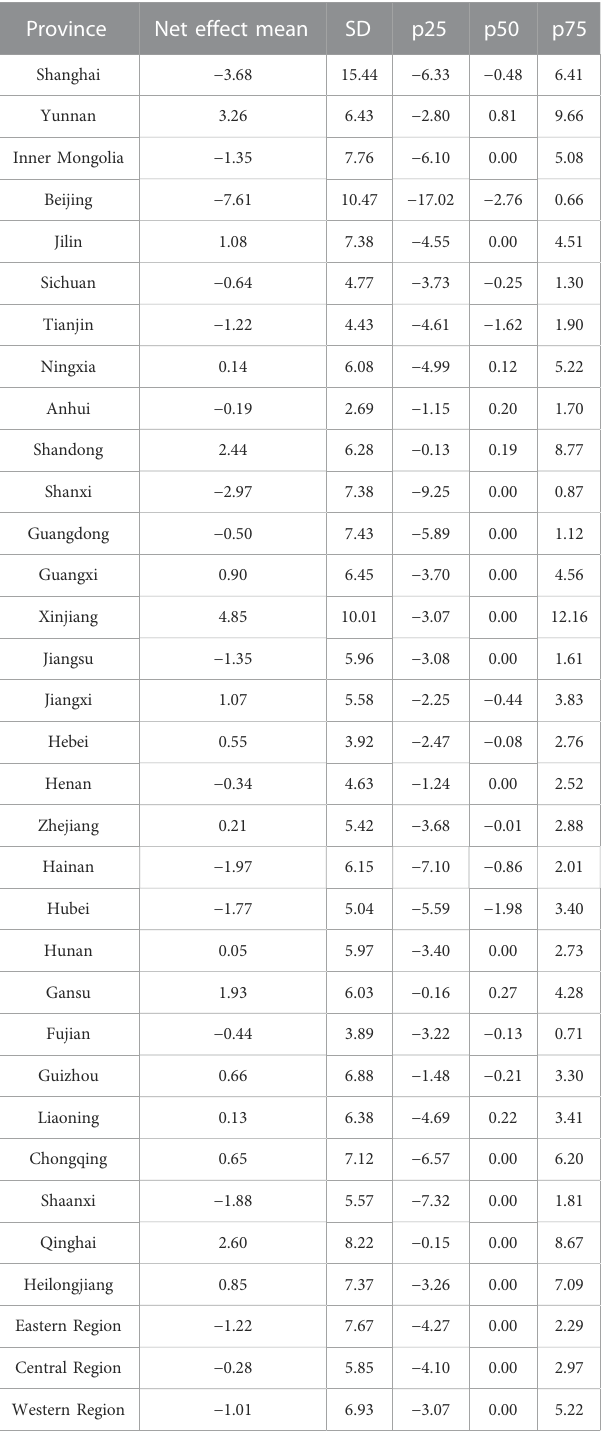
TABLE 5 Characteristics of the annual distribution of the net effect of the digital economy on air pollution (%).